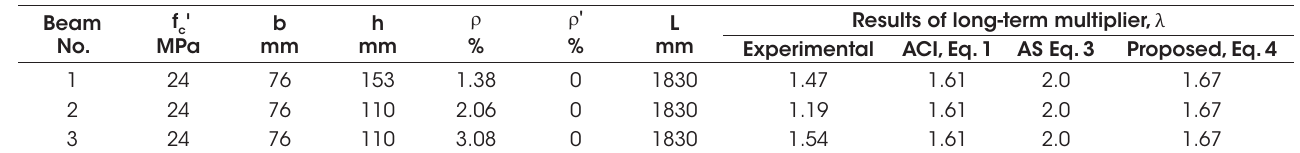
) with experimental results by [28], λ